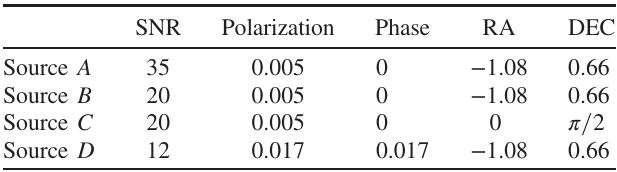
TABLE I. For all events the GPS time is 1 068 936 994.0, and the two component masses in the source frame are 1 . 4 M ⊙